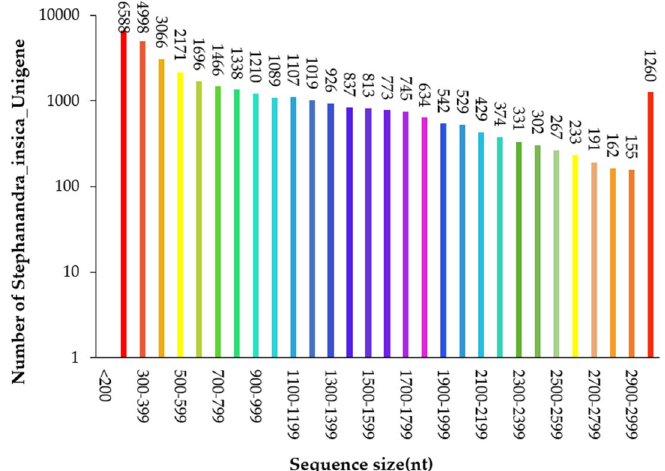
Figure 1. Sequence length distribution of the assembled unigenes.